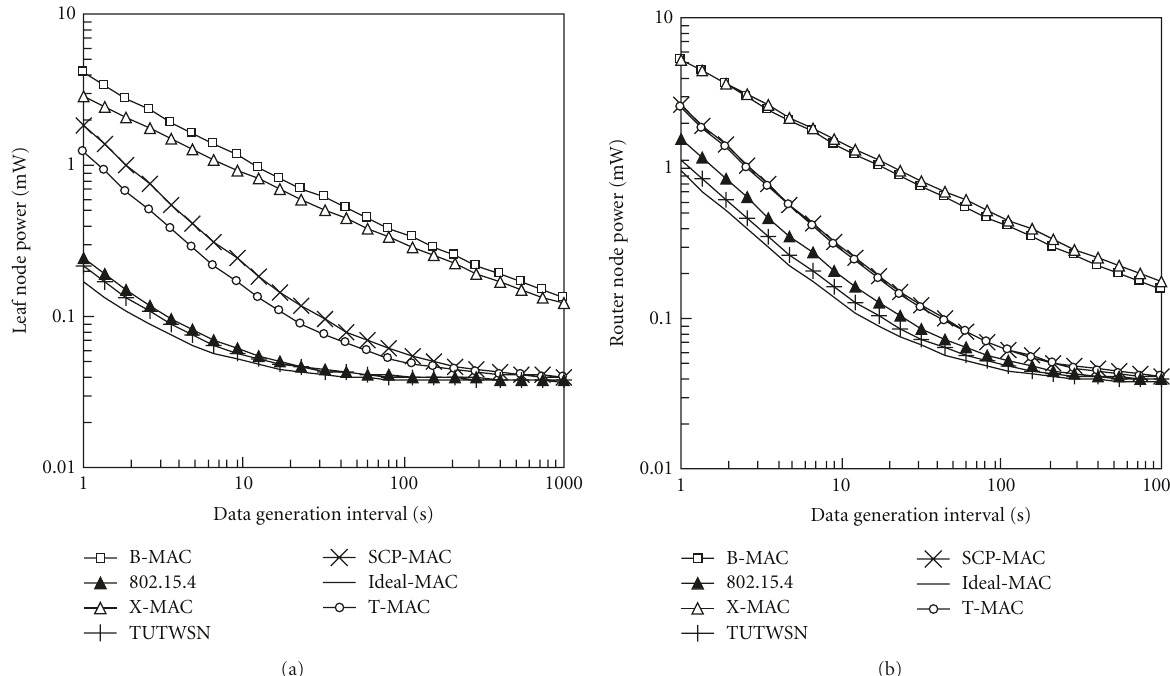
Figure 15: Power consumption comparison using the Low Rate (LR) platform.